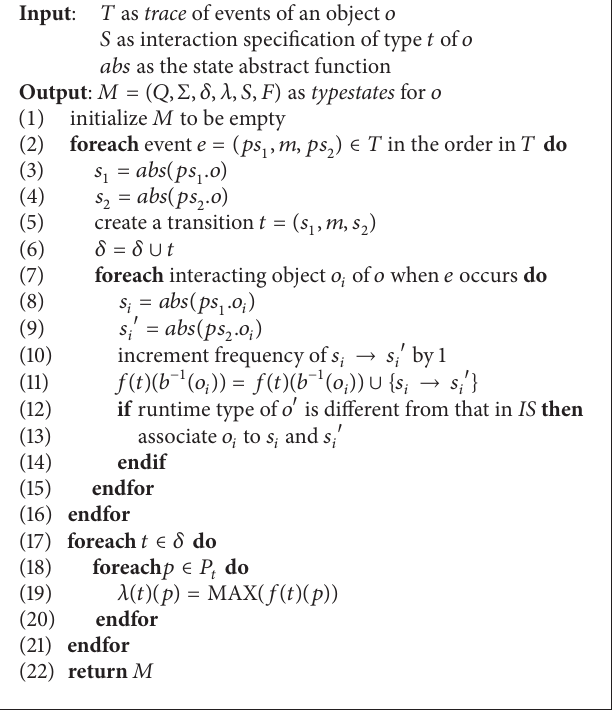
Algorithm 1: The algorithm to mine single object typestates annotated with